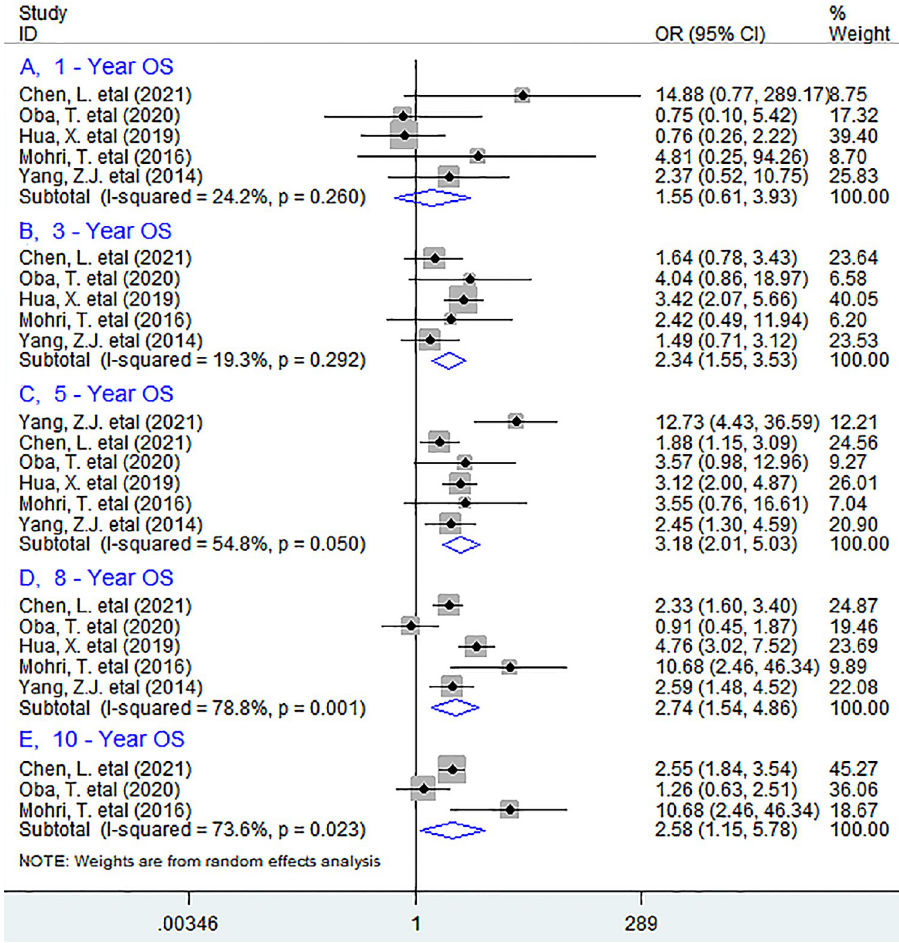
Fig 3. Forest plots describing ORs of the association between low baseline PNI and OS at 1-year(A), 3-year(B), 5-year(C), 8-year(D) and 10-year(E) in breast cancer patients. OR, odds ratios; PNI, prognostic nutritional index; OS, overall